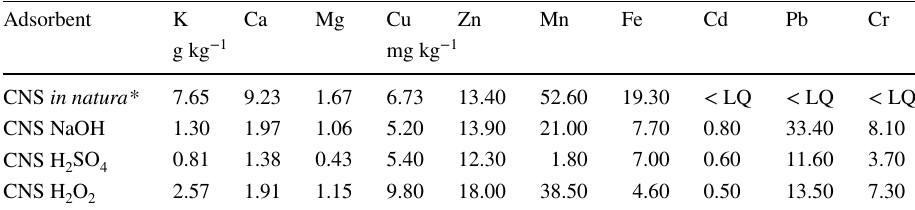
LQ (quantitation limit): K = 0.01; Ca = 0.005; Mg = 0.005 (g kg −1 ); Cu = 0.005; Fe = 0.01; Mn = 0.01; Zn = 0.005; Cd = 0.005; Pb = 0.01; Cr = 0.01 (mg kg −1 )